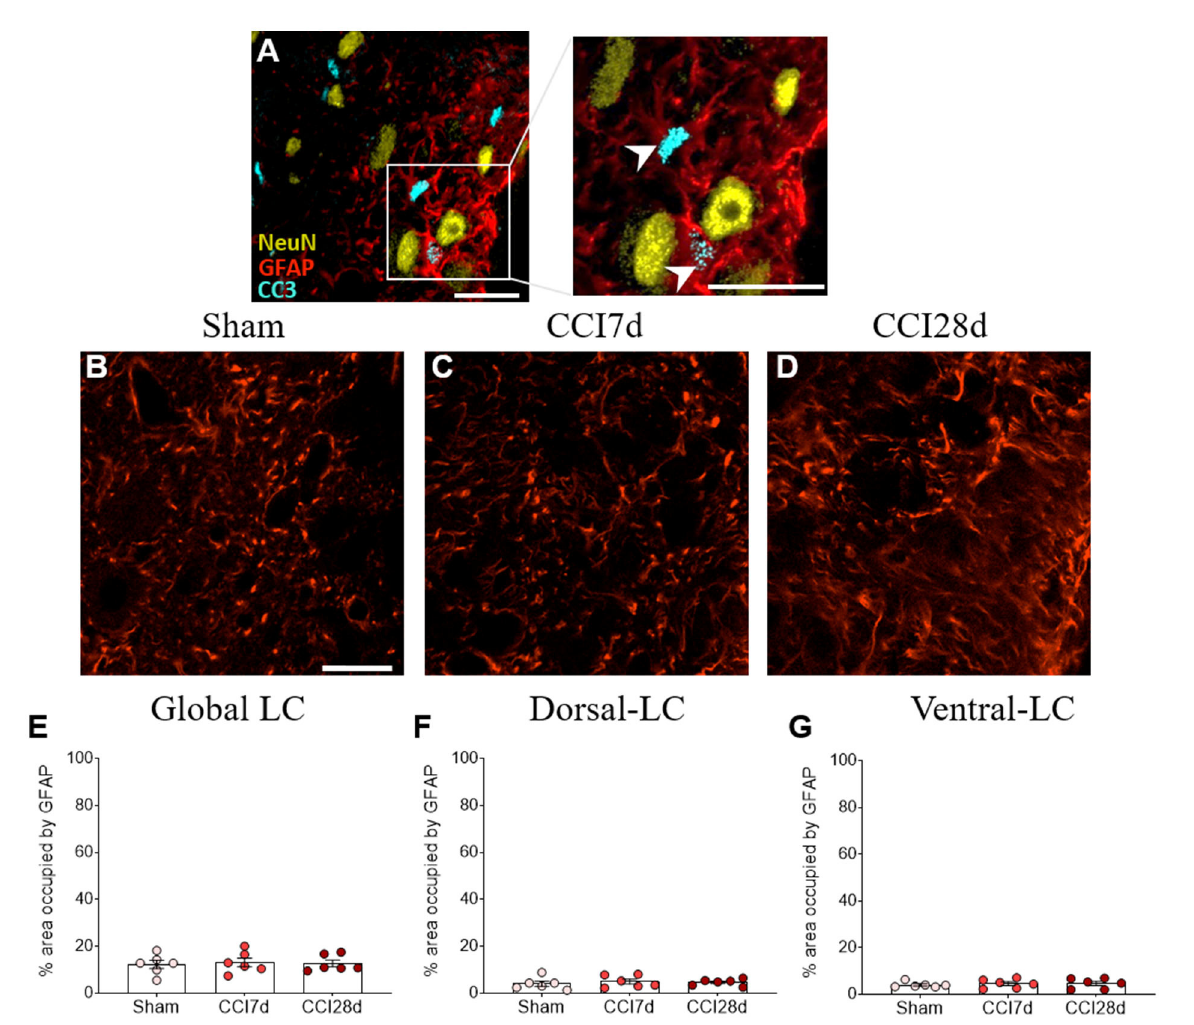
FIGURE7 Study of the CC3 in GFAP + or NeuN + cells in the LC. (A) Representative confocal images of CC3 + /GFAP + cells without NeuN (NeuN yellow, GFAP red, CC3 blue; scale bar, 20 µ m). (B–D) Representative confocal images of GFAP expression in (B) Sham, (C) CCI7d, and (D) CCI28d rats. (E–G) Quantification of the area occupied by GFAP in the (E) global, (F) dorsal, and (G) ventral LC. The data are presented as the mean ± SEM of three to four quadrants per section (three slices), one-way ANOVA followed by a Tukey’s